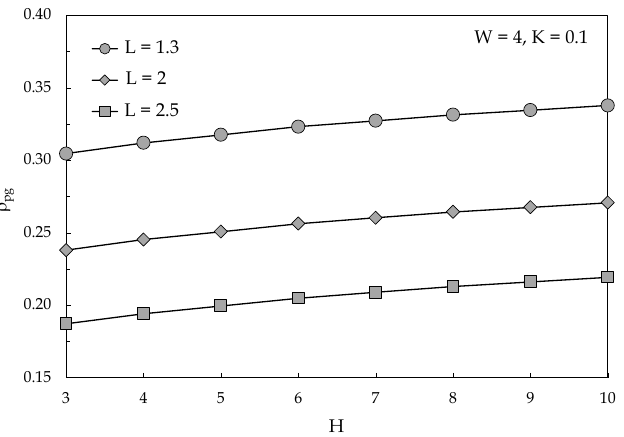
Figure 7. Distributions of the dimensionless thermal resistance ρ pg versus H using L as parameter.